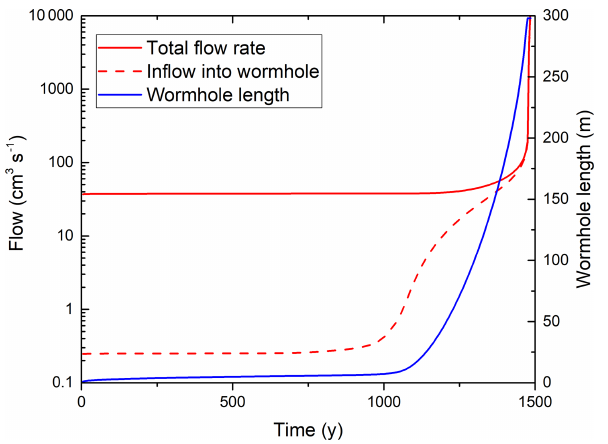
Figure 10. Profiles of aperture widths (solid lines) and saturation ratios ( c/c eq , dashed lines), along the wormhole at given